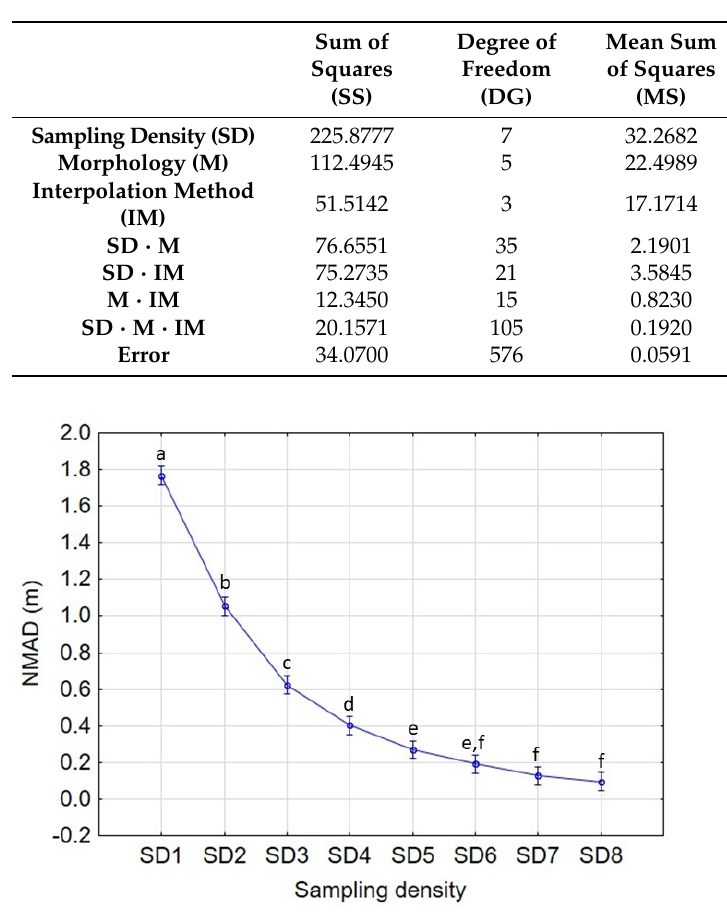
Figure 12. Trend plot of NMAD vs. Sampling Density factor. For each SD all morphologies and interpolation methods are included. Vertical bars denote 95% confidence intervals. Different letters between sampling densities indicate significant differences according to Tukey’s test ( p < 0.05).